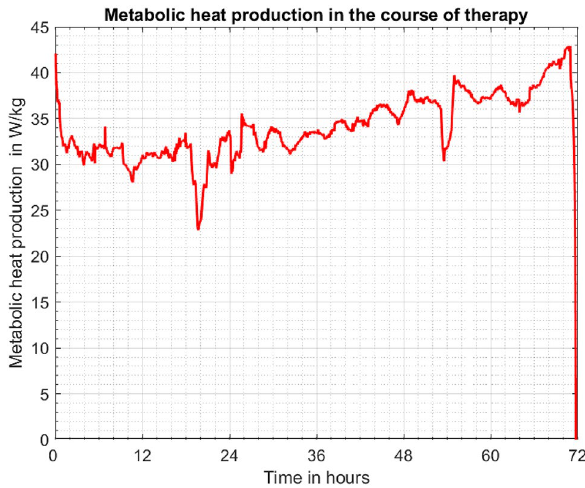
Figure 8. Metabolic heat production related to neonate’s body